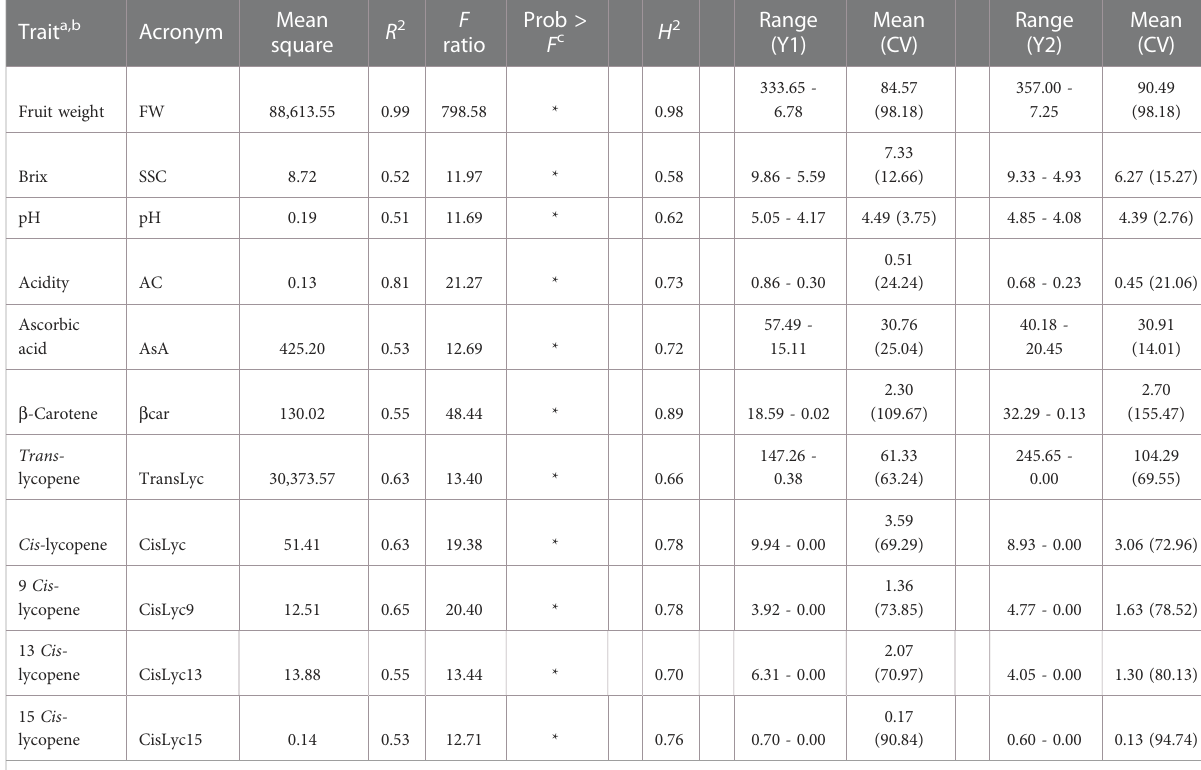
TABLE 2 Descriptive statistics, broad-sense heritability ( H 2 ), range, mean, and coef fi cient of variation in percentage (in bracket) for the traits analyzed on 60 heirloom accessions during two seasons (Y1 and Y2).